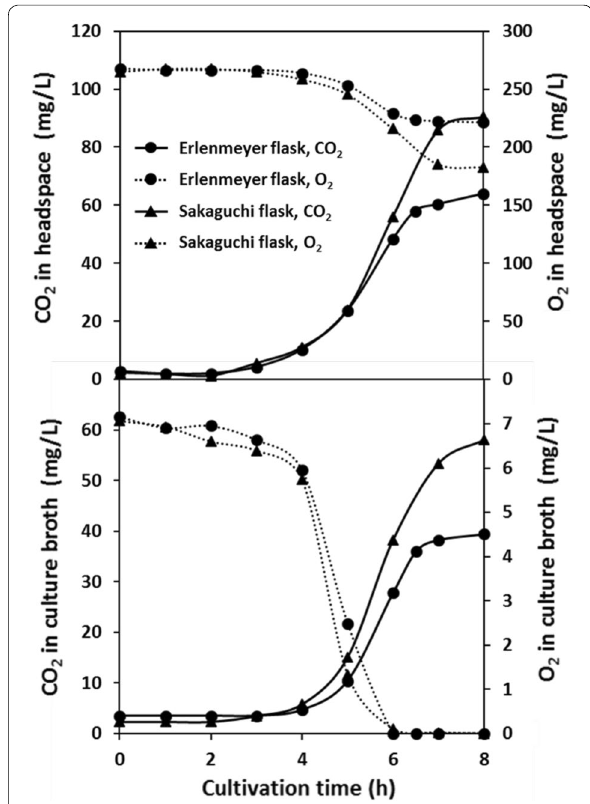
Fig. 1 Real-time CO 2 and O 2 concentrations in conventional flasks in shake culture of E. coli K12 IFO3301. Shake-flask culture conditions for both flasks were set as 100 mL of LB medium at 30 °C, and 200 rpm in the case of Erlenmeyer flask and 120 strokes/min shaking frequency and 70 mm shaking diameter in the case of Sakaguchi flask. Both 500-mL Erlenmeyer and Sakaguchi flasks were equipped with breathable culture stoppers and